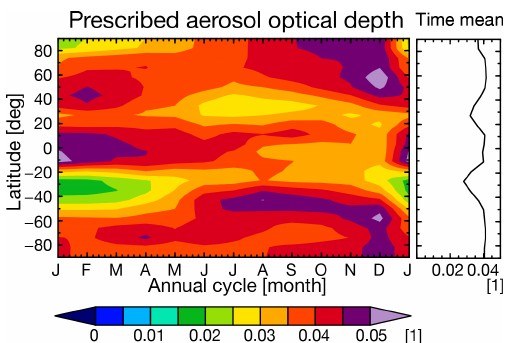
Figure 1. Annual cycle and latitudinal distribution of the prescribed aerosol optical depth provided from the GeoMIP for G4 experiment and used in BNU-ESM, MIROC-ESM, and MIROC-ESM-CHEM. Line graph shows the annual